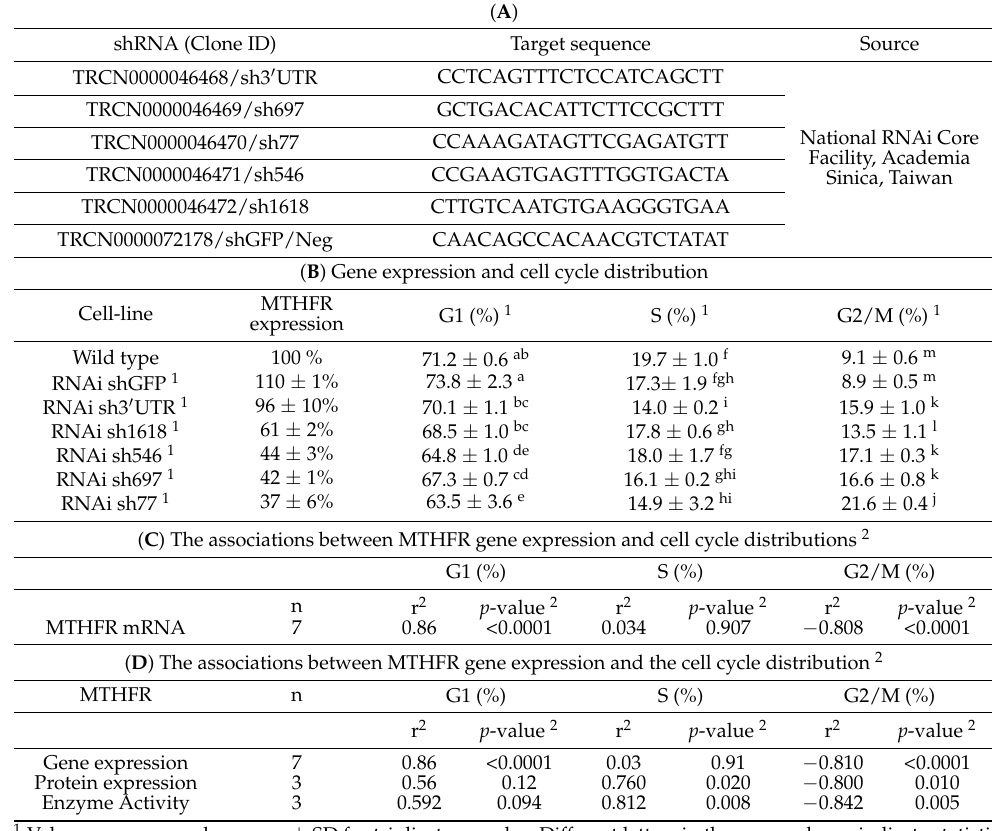
Table 1. MTHFR knockdown alters cell cycle distribution (%) in HepG2